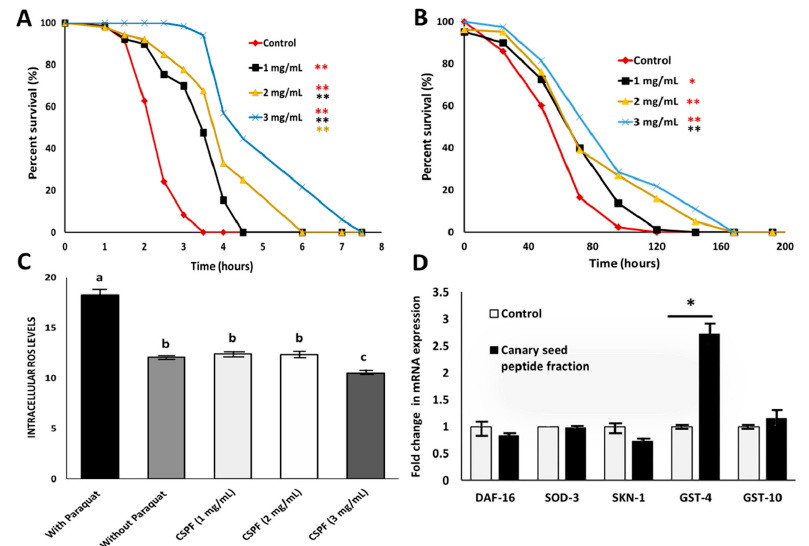
Figure 2 . In vivo antioxidant activity of canary seed peptide fraction (CSPF), using a C. elegans model. ( A ) Survival analysis of C. elegans pre-exposed to CSPF for 24 h followed by acute oxidative stress induction with tert-butyl hydrogen peroxide (t-BOOH). ( B ) Survival analysis of C. elegans pre-ex- posed to CSPF for 24 h followed by chronic oxidative stress induction with paraquat. ( C ) Intracel- lular accumulation of reactive oxygen species (ROS) in C. elegans after pre-exposure to CSPF for 24 h followed by paraquat for 48 h. ( D ) Relative mRNA levels of expression of DAF-16, SOD-3, SKN- 1, GST-4, and GST-10 after 24 h exposure with 3 mg/mL of CSPF using ACT-1 as an internal control. Bars and lines represent mean values ± standard deviation. Three independent experiments were